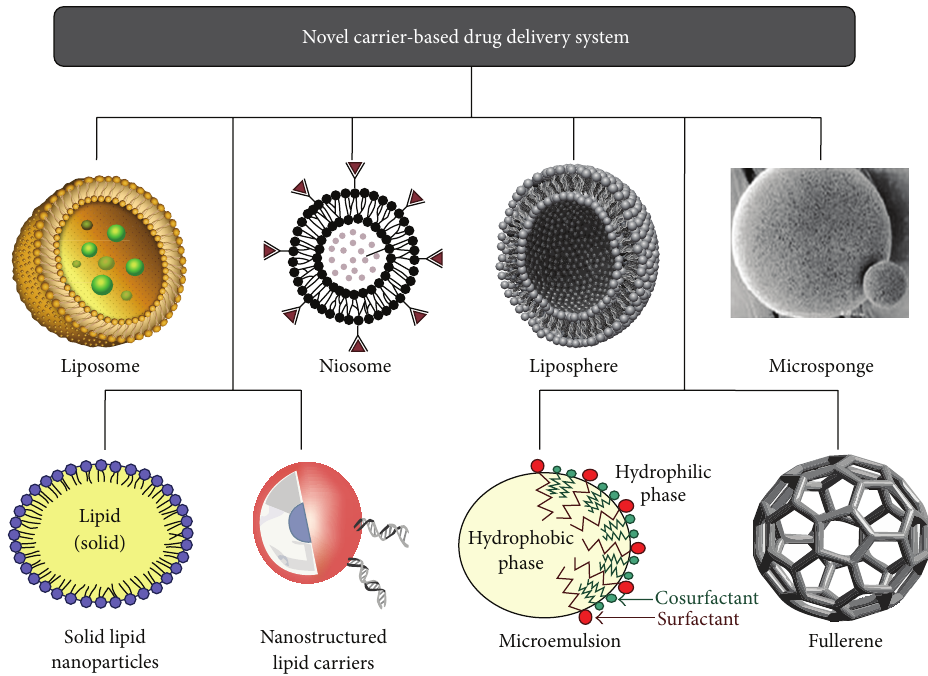
Figure 4: Novel carrier-based drug delivery system for treatment of